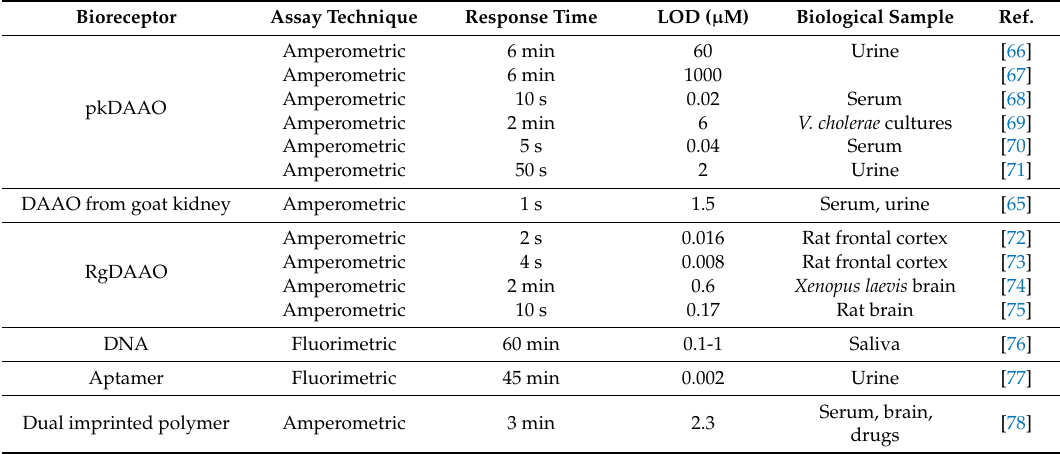
Comparison of analytical properties of di ff erent biosensors to detect D-AAs for biomedical